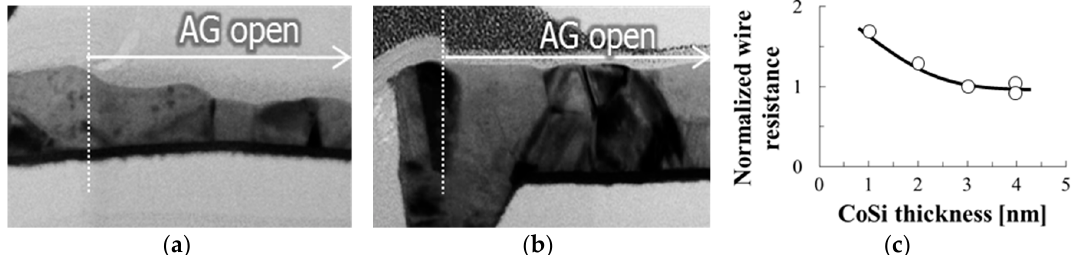
Figure 7. Cross-sections of ( a ) unprotected Cu and ( b ) Cu protected with CoSi ( c ) wire resistance of the 40 nm-wide wire in the AG region with respect to the CoSi thickness.